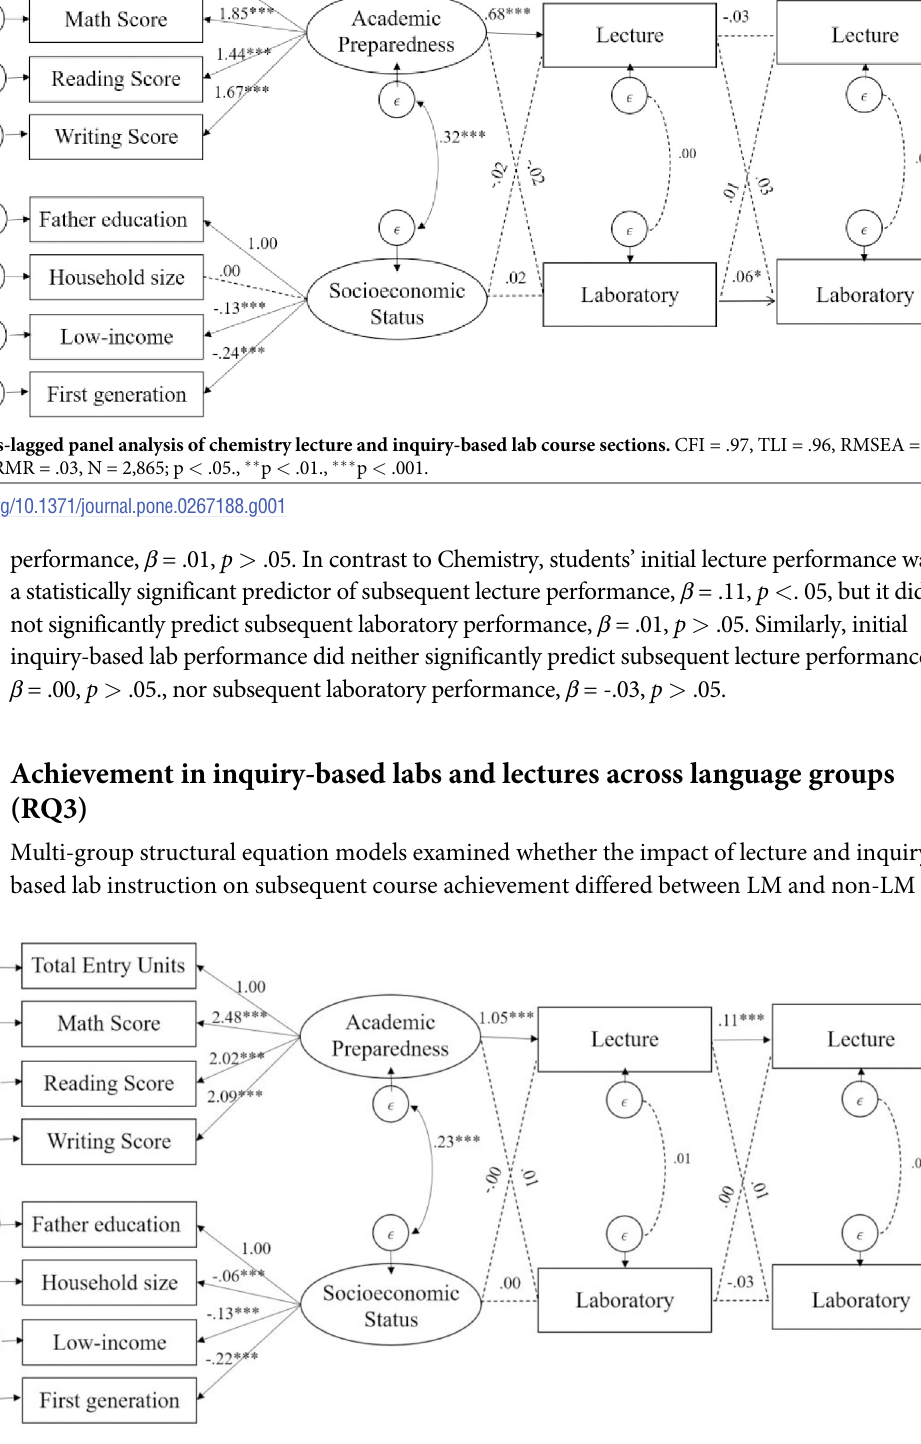
Fig 2. Cross-lagged panel analysis of physics lecture and inquiry-based lab course sections including transfer and international students. CFI = .99, TLI = .99, RMSEA = .02 [.02, .03], SRMR = .02; N = 4,046; p < .05., �� p < .01., ��� p <